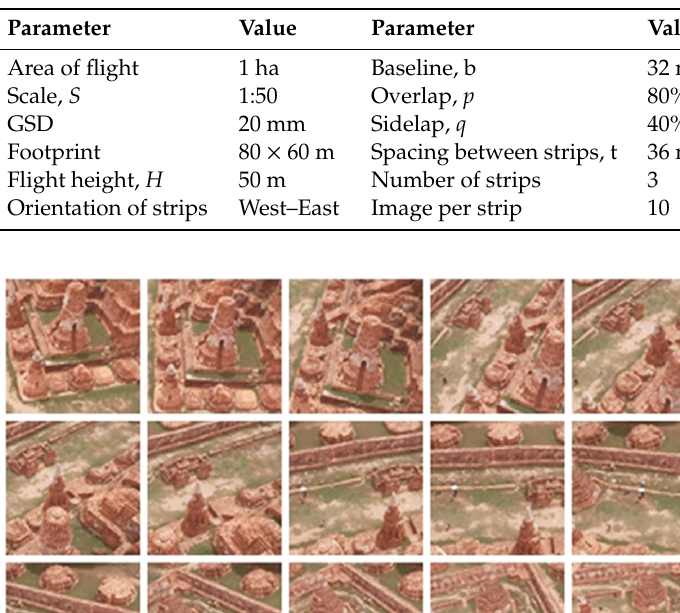
Table 1. Specifications of unmanned aerial vehicle (UAV) flight planning.